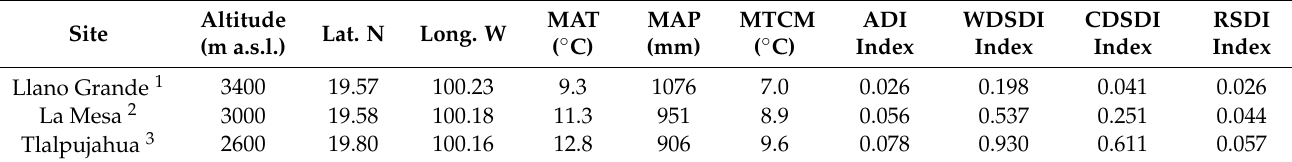
Table 3. Location and some climatic variables (their acronyms as in Table 2) of sites of tests of provenances in common